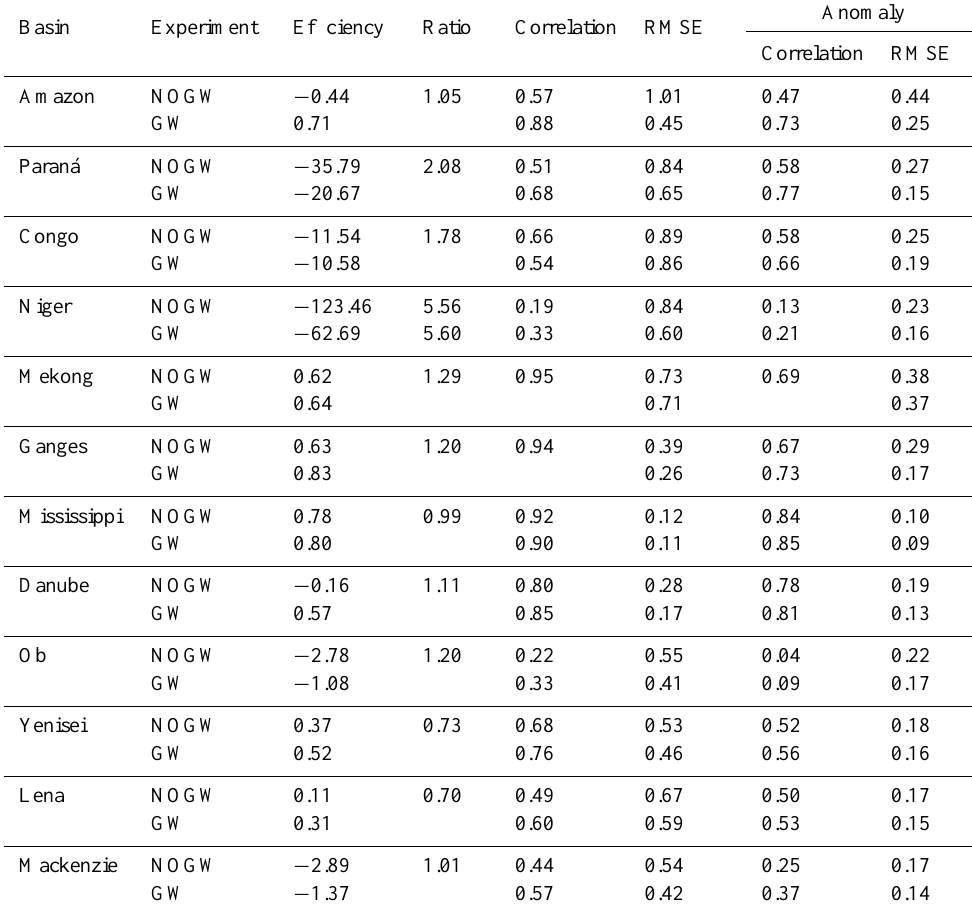
Table 3. Statistics of NOGW and GW calculated over the observation period of each station shown in Fig. 5. Efficiency, ratio, correlation and RMSE (mm day − 1 ) are given, as are correlation and RMSE (mmday − 1 ) of the monthly anomalies.